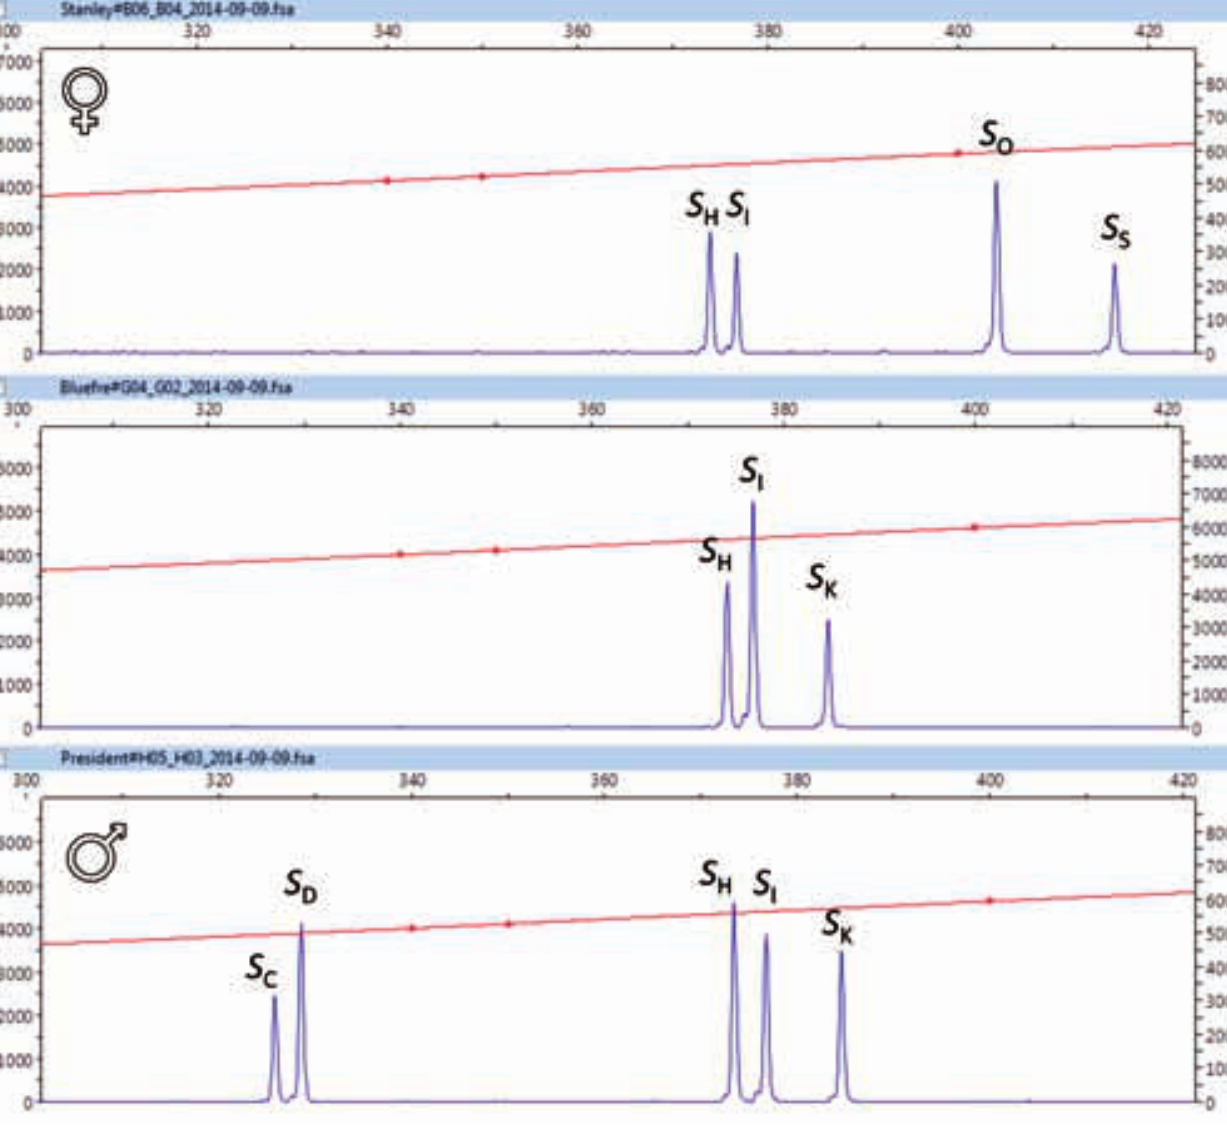
Figure 1. Chromatogram of the fluorescently labelled first intron fragments of the S-RNase gene indicating S -alleles in 3 plum cultivars. Bluefre ( S Stanley (